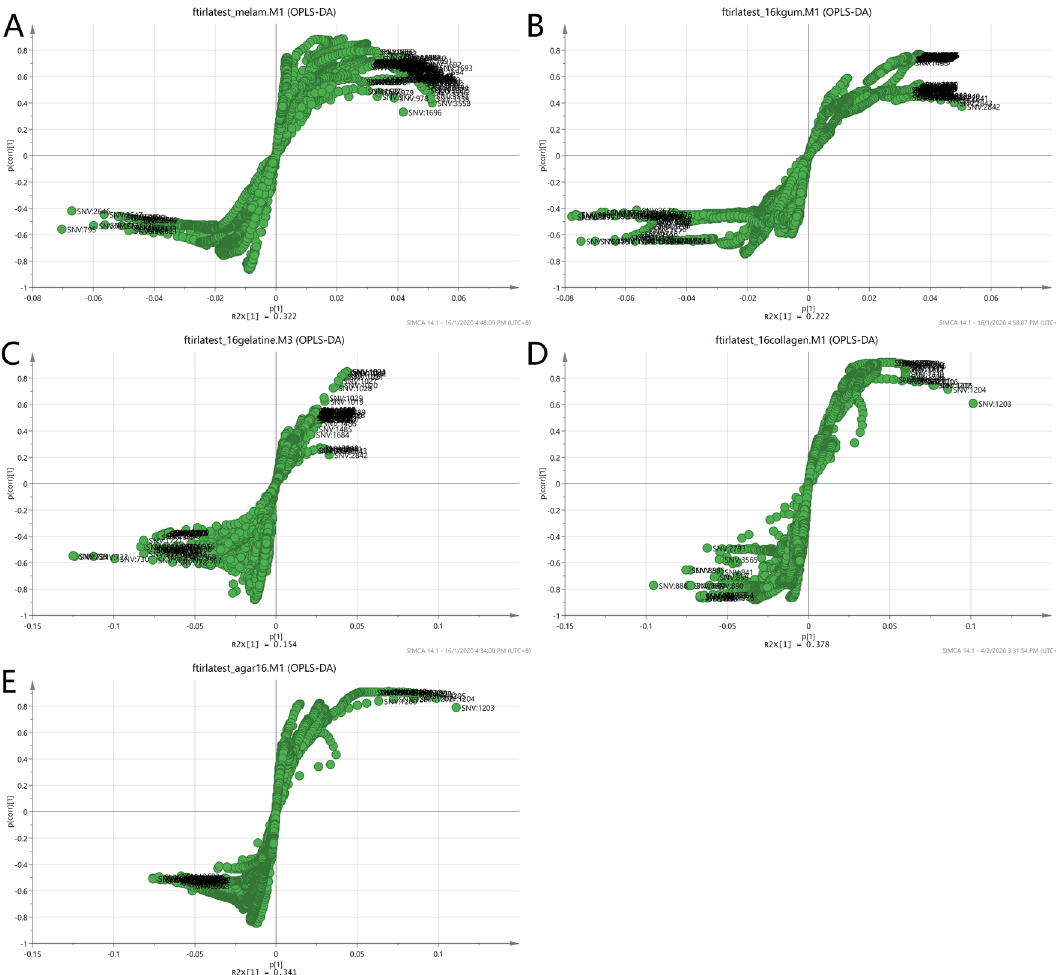
Figure 14. The S-plot of the two-class OPLS-DA model of the variables among the samples using MIR spectra (( A ) melamine, ( B ) karaya gum, ( C ) gelatine, ( D ) collagen and ( E ) nutrient agar). Each point represents the wavelength of the spectra. The plot at the outermost is the factor contributing to the grouping of the